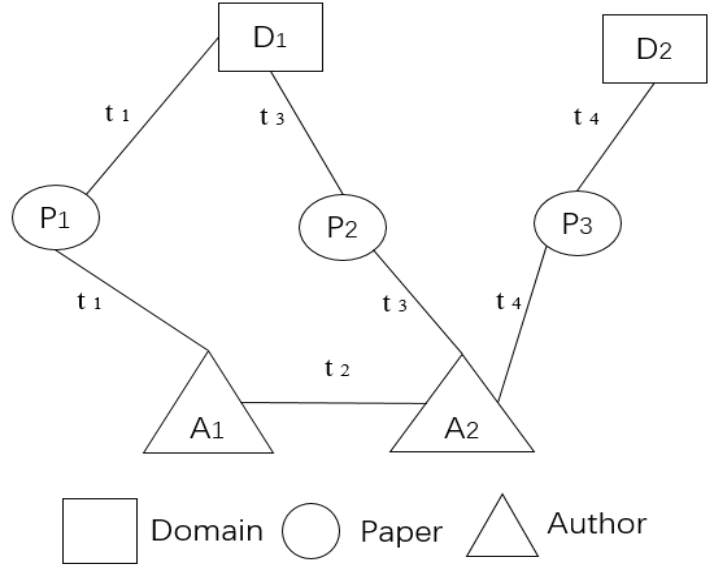
Figure 1. The Structure of citation DHIN. For example, if an author (A 1 ) published the paper (P 1 ), which belongs to the domain (D 1 ), timestamp t 1 is established between A 1 -P 1 and P 1 -D 1 .